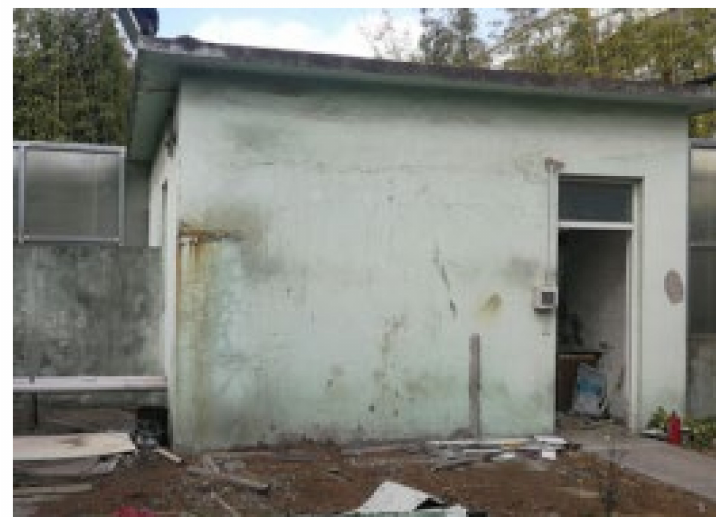
Figure 3. The old building of the water quality monitoring station.